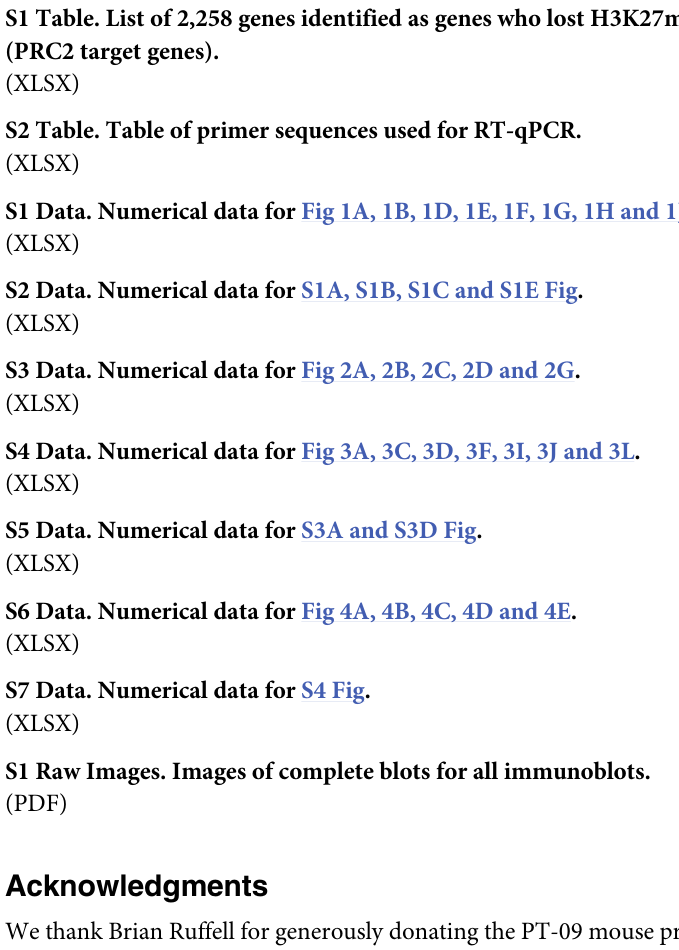
the 2 inhibitors. ( D ) Quantification of ATP levels after 8 hours of treatment with DMSO, EZH2i, HDACi, or the combination using CellTiter-Glo. Box plot reports the mean of 5 bio- logically independent samples with whiskers reporting minimum and maximum. P values measured by unpaired one-tailed homoscedastic Student t test (S6 Data). S4 Fig. Related to Fig 4. Correlation plot of EZH2 mRNA and ATF3 mRNA expression in Taylor and colleagues dataset [46] (S7 Data). S1 Table. List of 2,258 genes identified as genes who lost H3K27me3 in response to EZH2i (PRC2 target genes). S2 Table. Table of primer sequences used for RT-qPCR.